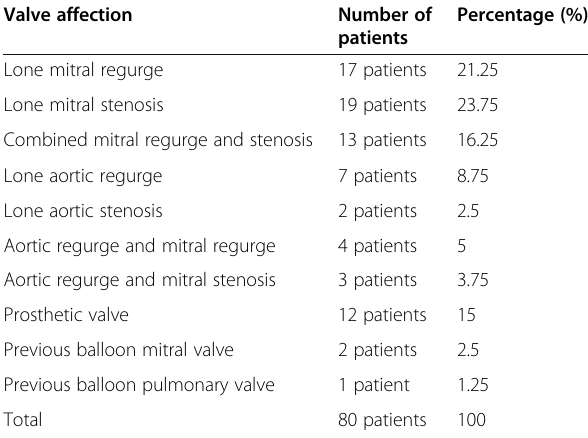
Table 2 Valvular affection between patients